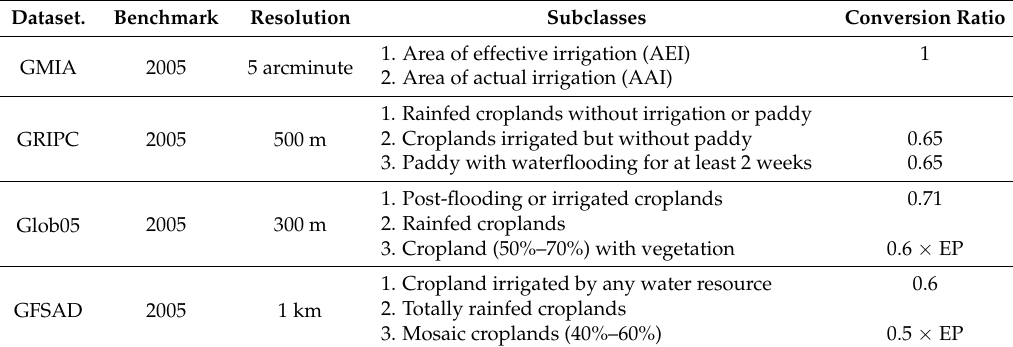
Table 1. Summary information of four datasets